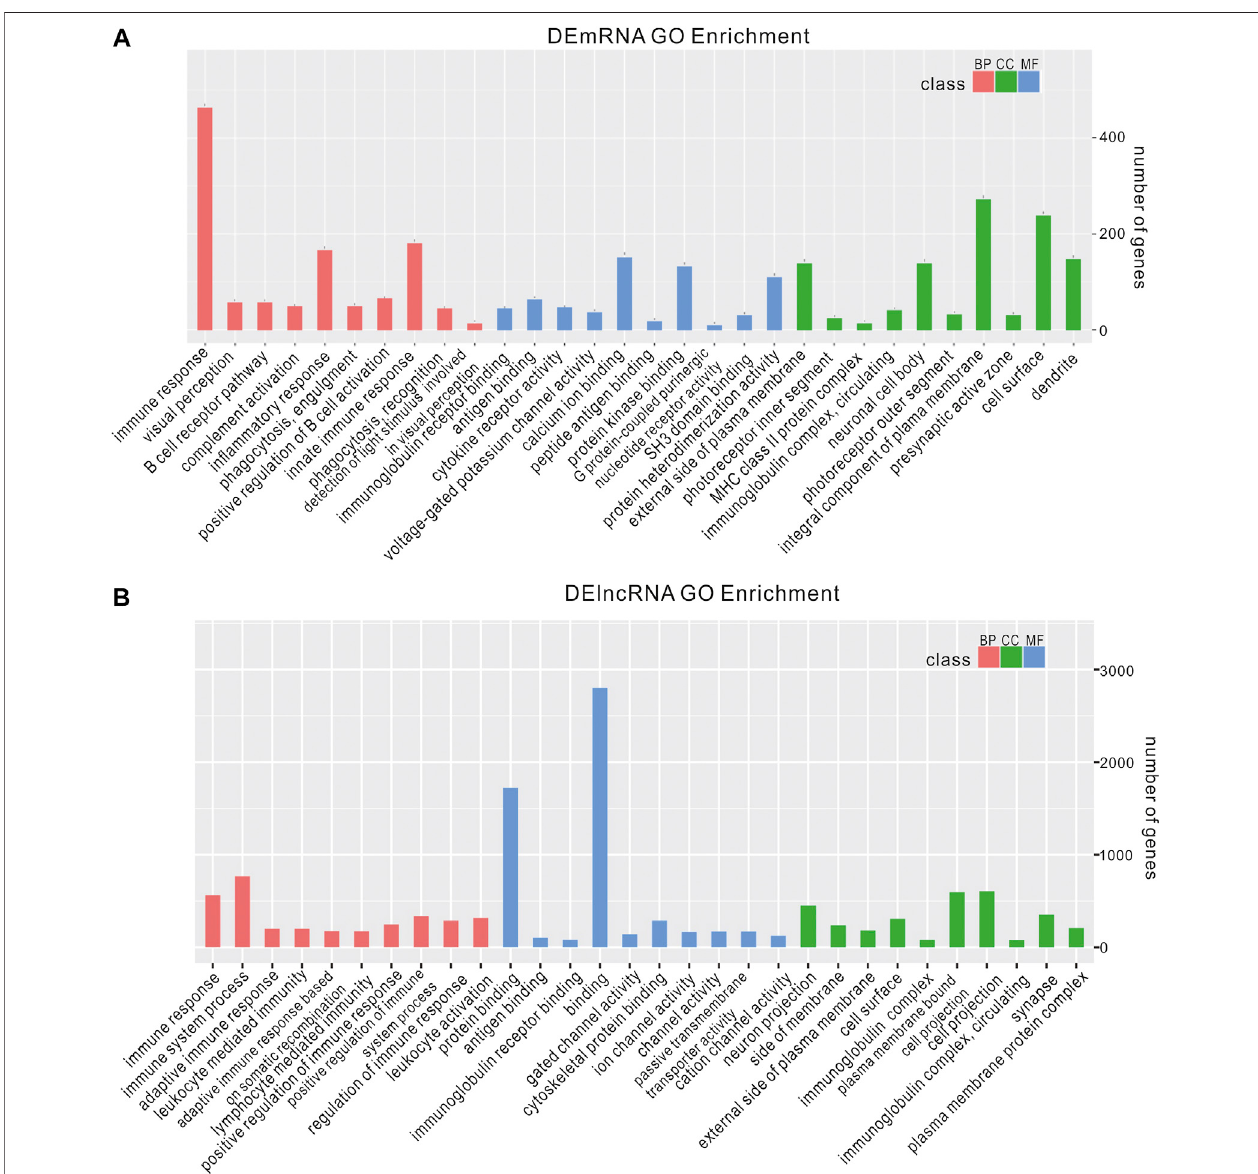
FIGURE3 | Enriched GOof DEmRNAs and DElncRNAs. top 10 most enriched GO for DEmRNAs (A) DElncRNAs (B) inEAU in terms of biological processes (BP), cellular component (CC), and molecular function (MF).